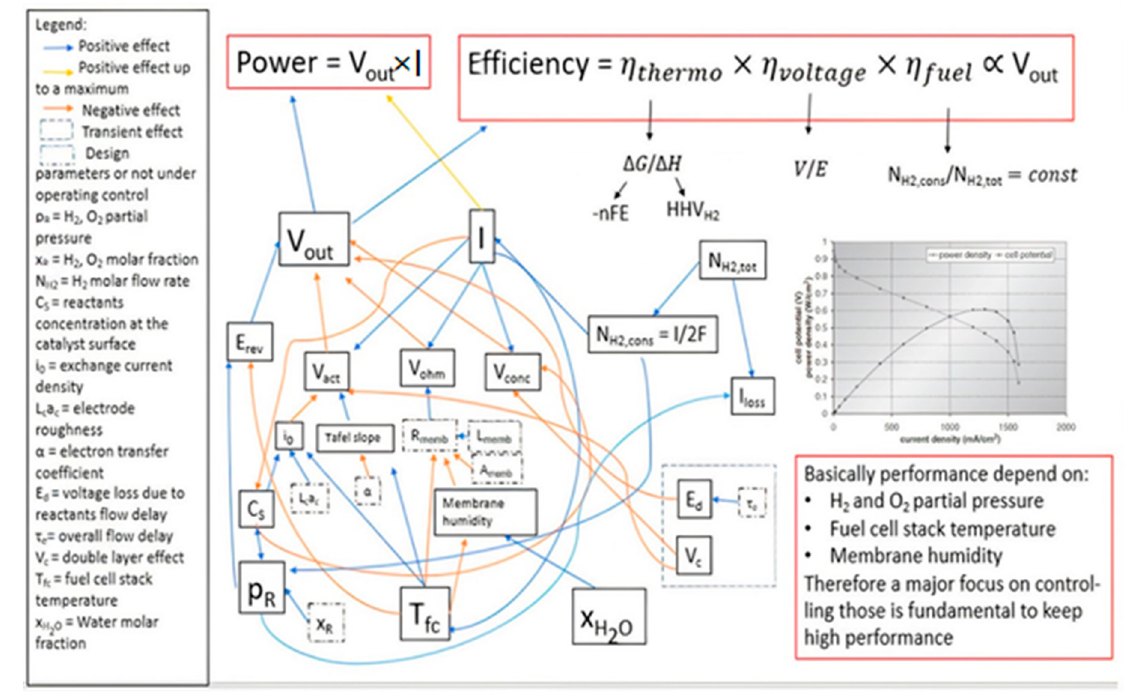
Figure 9. Map of the influence of operating parameters on fuel cell performance. A blue arrow corresponds to a concordant (positive) relationship between the connected variables while an orange arrow corresponds to a discordant (negative)